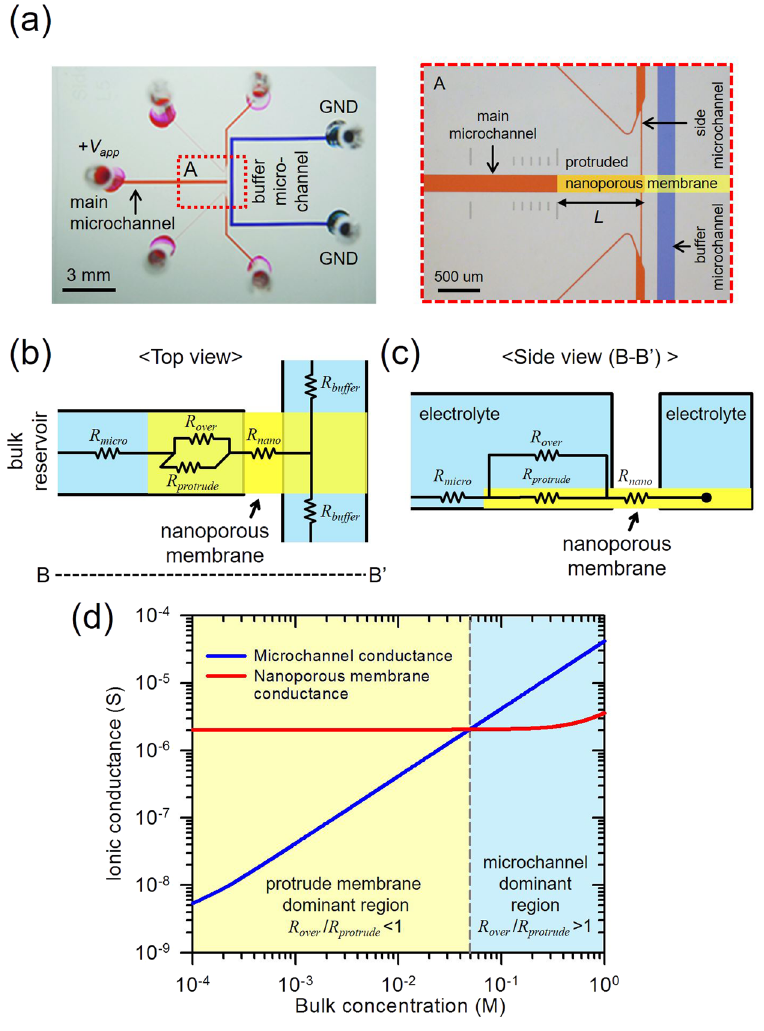
Figure 1. ( a ) Snapshot and microscopic view ((A) in red box) of the fabricated non-destructive cellular preconcentrator. L was the length of protruded nanoporous membrane from the main microchannel. Schematics of ( b ) top and ( c ) side view of the proposed devices with equivalent electrical resistors (not to scale). ( d ) Calculated ionic conductance of microchannel and nanoporous